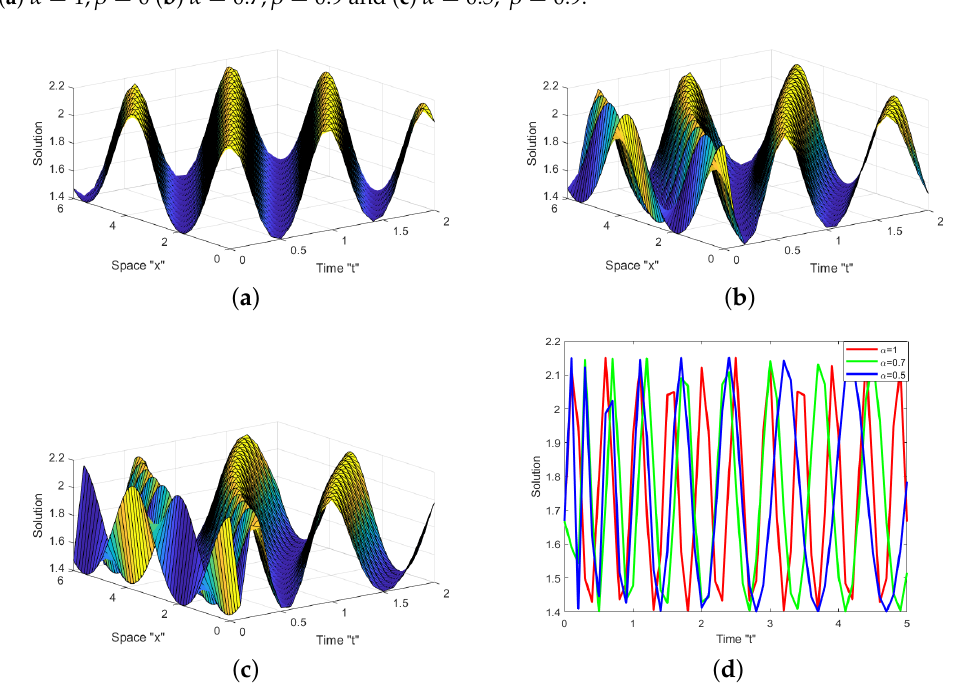
Figure 3. For Equation (39), ( a – c ) with parameters m = 0.5, ξ 1 = 1, ξ 2 = 2, ξ 3 = − 1, ξ 4 = − 1, √ ( 3 − 3 λ = 1 13 ) , x ∈ [ 0,6 ] , t ∈ [ 0,2 ] , y = ω = z = 1, displays the 3D representations and ( d ) 2 displays the 2D plot for various values of α at t = 100; there is no overlap between the curves of the solution. ( a ) α = 1, β = 0 ( b ) α = 0.7, β = 0.9 and ( c ) α = 0.5, β =